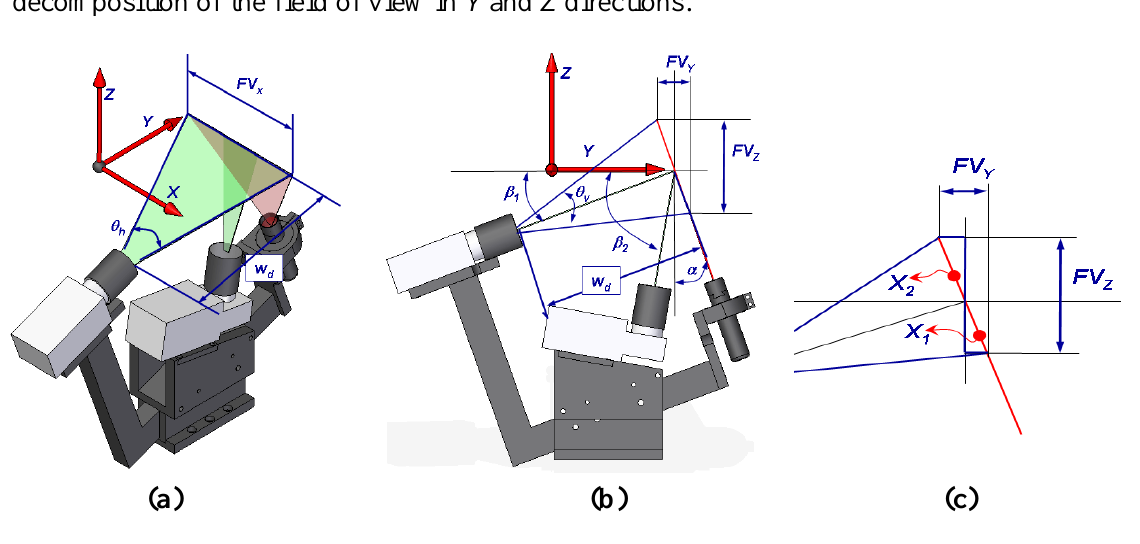
Figure 2. (a) Field of view Y coordinate [mm]. (b) Field of view Z coordinate